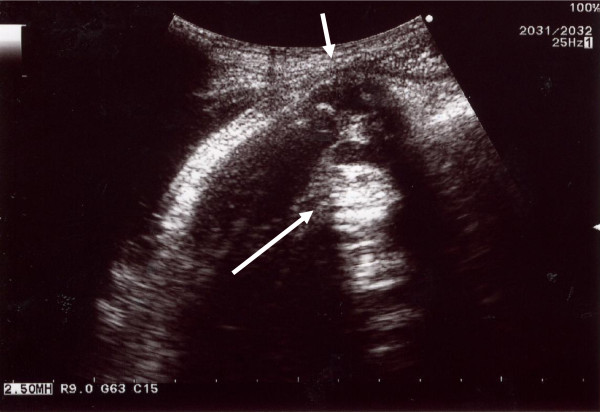
An abdominal ultrasound image of the uterine wall and the fetal minor part. The small arrow indicates a thin uterine wall, which is slightly bulging. Beneath the thin uterine wall a fetal minor part (large arrow) is visible, which was palpated as a hard mass through the abdomen.